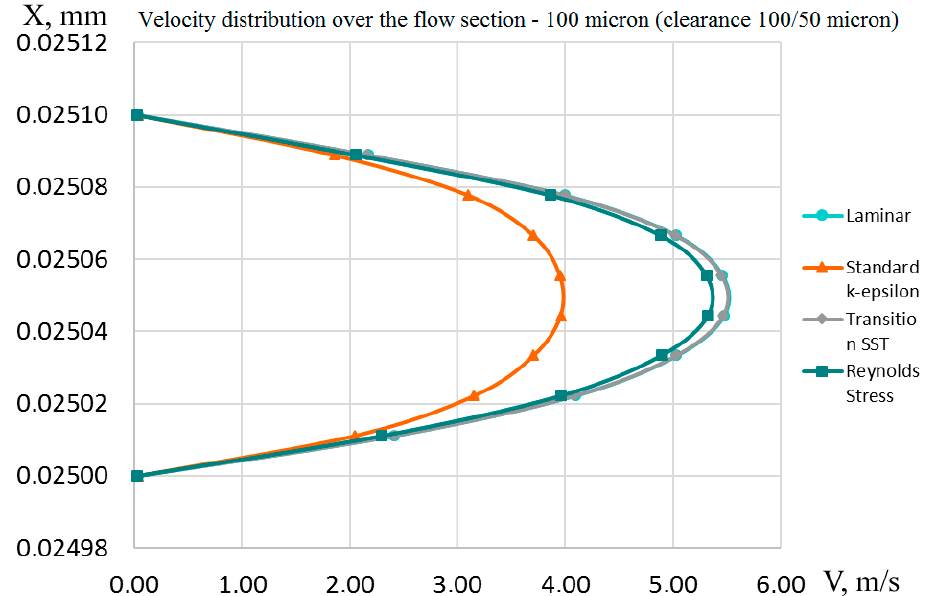
Figure 21. Velocity distribution over the flow section (laminar and transition SST curves match). For the reverse flow diagrams, the velocity distributions differ primarily, qualitatively and slightly quantitatively from the diagrams in the forward flow: